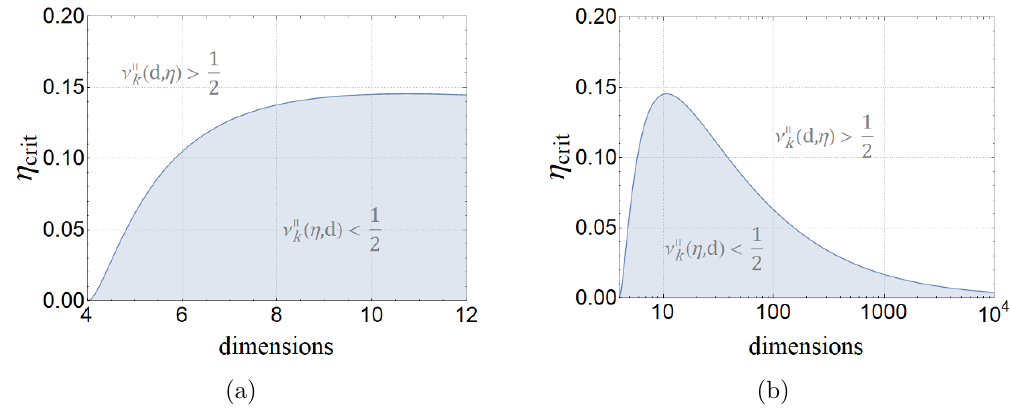
Figure 8. The critical value of the metric parameter (cid:17) (above which no spectral weight exists) is plotted as a function of dimension d . At d = 11, the (cid:17) crit reaches a maximum value. In the large d limit non-zero low energy spectral weight is suppressed.